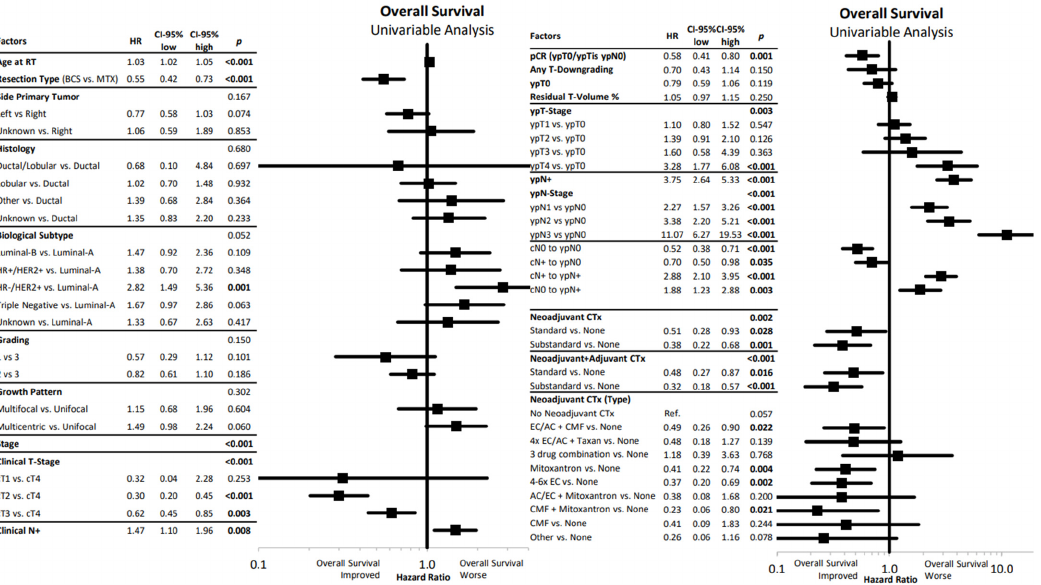
Figure 3. Univariate Cox regression analysis of overall survival with hazard ratios and their corresponding confidence intervals presented in a forest plot. RT: Radiotherapy, BCS: breast- conserving surgery, MTx: mastectomy, HR+: hormone receptor positive, HER2: human epithelial growth factor receptor 2, TN: triple negative, G: grading, HR: hazard ratio, CI: confidence interval, pCR: pathologic complete response, c: clinical, T: tumor, N: nodal, CTx: chemotherapy, AC: adriamycin/cyclophosphamide, EC: epirubicine/cyclophosphamide, CMF: cyclophosphamide, methotrexate, fluorouracil. Statistically significant differences are marked in bold.